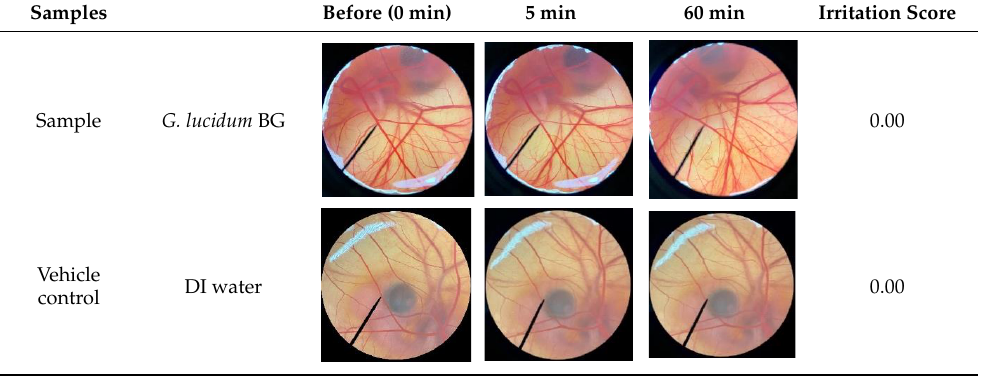
Table 6. Water-holding capacity (WHC), water-binding capacity (WBC), swelling capacity (SC), and oil-holding capacity (OHC) of antler-type G. lucidum BG and commercial BG.